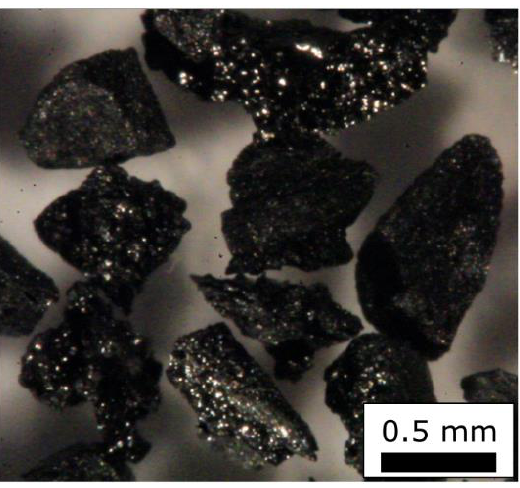
Figure 6. Coal particles applied in calibration (0.5 to 0.6 mm size fraction).